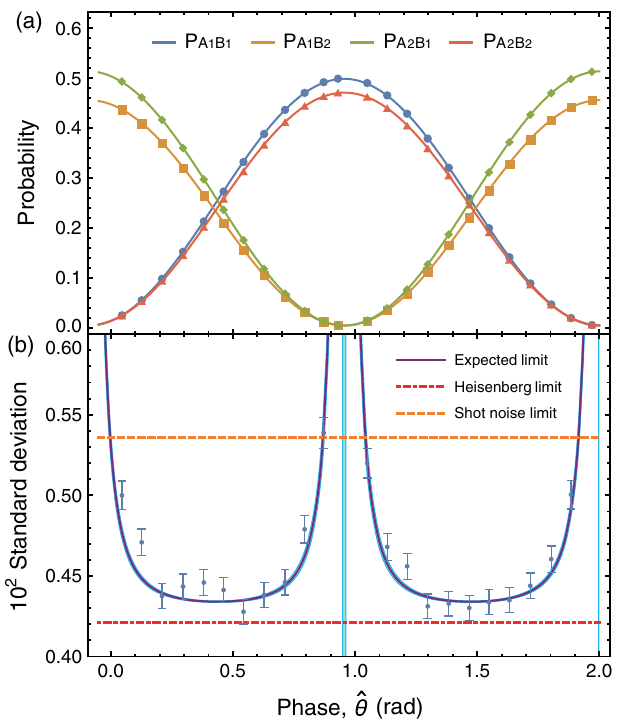
FIG. 2. Experimental results for a distance of 240 m. (a) Ex- perimental interference fringes of four detection events versus different phase shifts. The horizontal axis represents ^ θ ∈ ˆ θ ½ 0 ; ð 2 π = 3 Þ(cid:2) . (b) Experimental phase ¼ ð θ A − 2 θ B Þ = 3 , standard deviation (purple line) per trial versus different phase shifts. The shaded areas (blue narrow bands) correspond to the 99.7% confidence regions, which are calculated from the uncertainty of the fit parameters. Orange dashed line: theoreti- cal limit for SNL. Red dashed line: theoretical bound for HL. The error bars of the standard deviations are discussed in the main